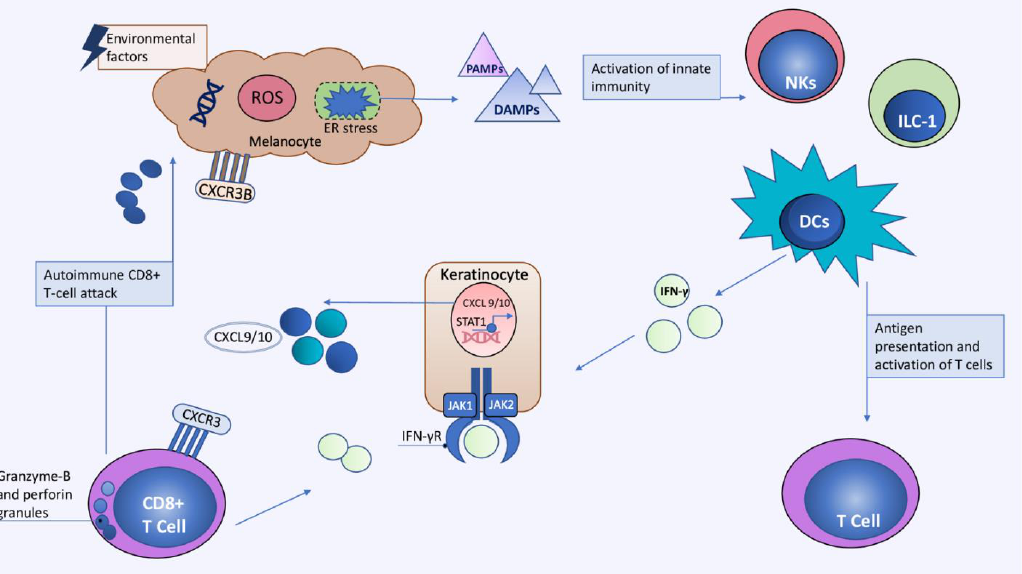
Figure 1. Main effector cells and signaling pathways in the initial stage of vitiligo. Vitiligo immunopathogenesis is characterized by a complex inflammatory cascade that is initiated by innate immune cells (DCs, NK cells, and ILC-1 cells) which recognize signals from stressed